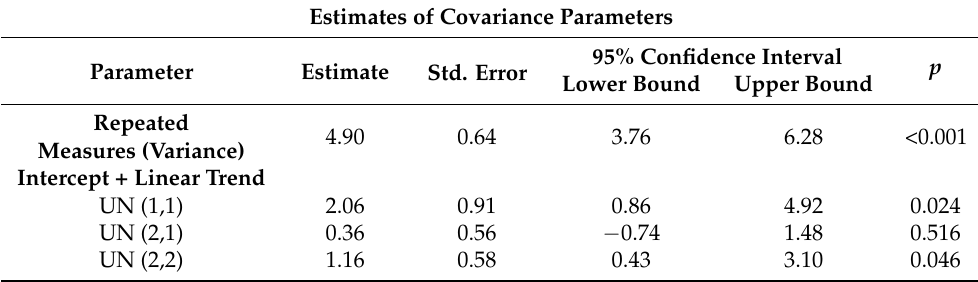
Table 5. The random effect of the “time” as a linear trend in the model. Estimates of Covariance